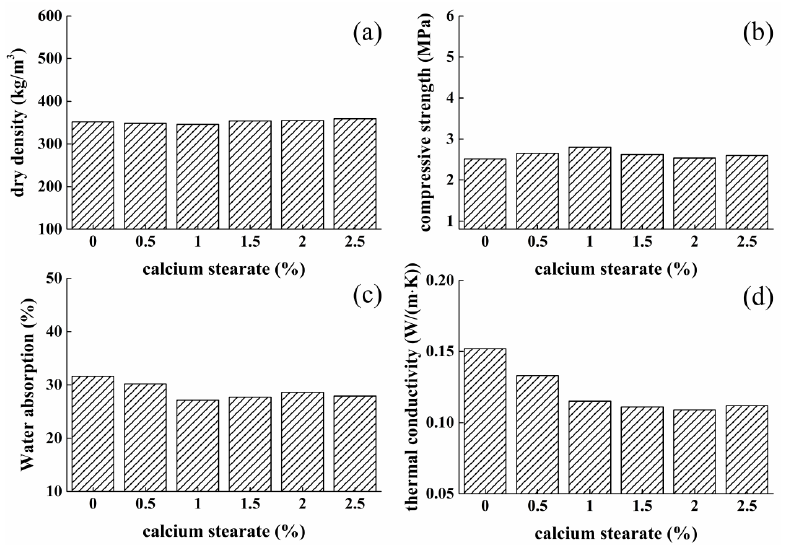
Figure 6. Effect of calcium stearate content on properties of foamed concrete: (a) dry density; (b) compressive strength; (c) water absorption; (d) thermal conductivity.